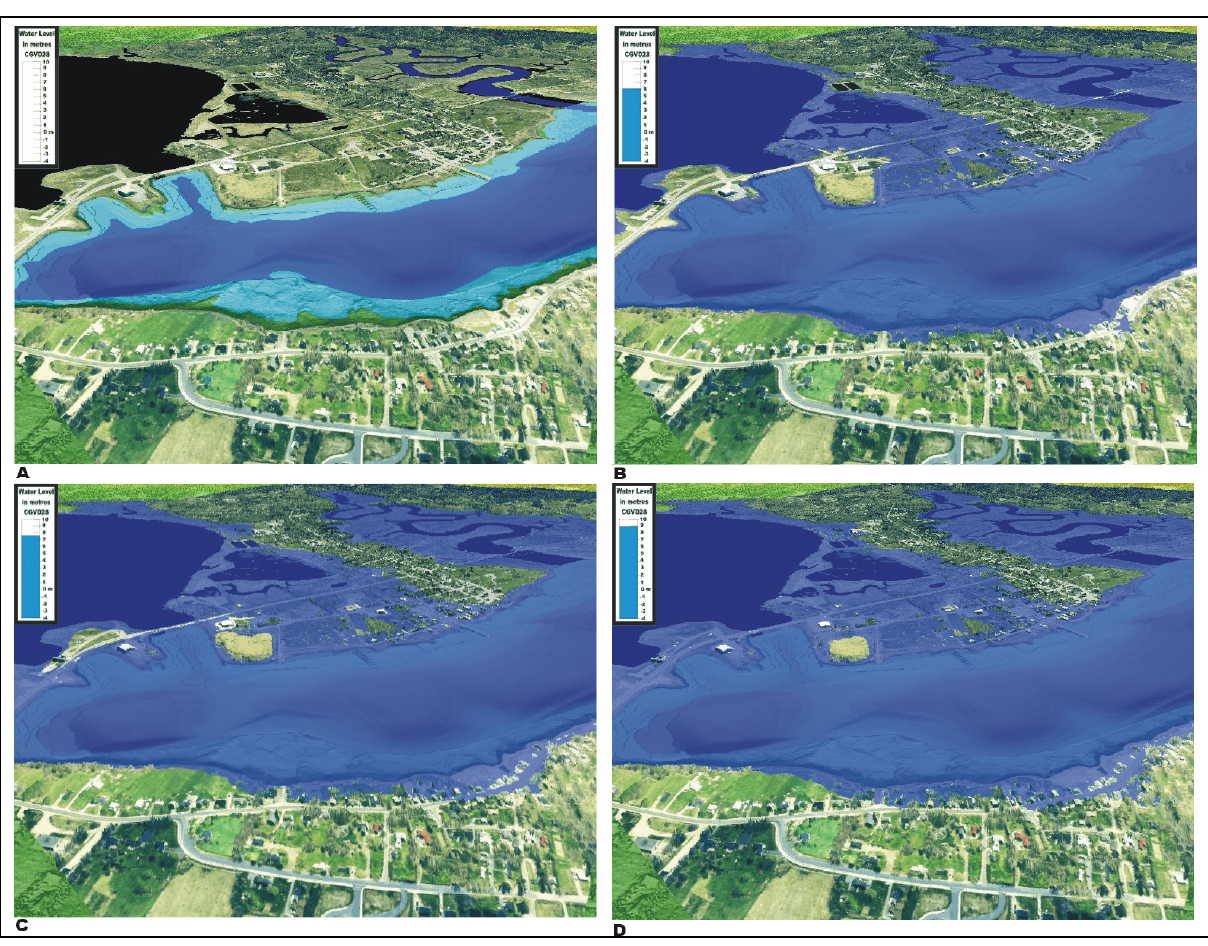
Figure 7. Perspective views of Annapolis Royal looking southeast. May 2003 color orthophoto and bathymetric data overlayed on the LiDAR DSM. (A) low tide (−4 m); (B) Groundhog Day storm in 100 years with a conservative RSL of 80 cm, (6.2 m); (C) Groundhog Day storm in 100 years with a potential RSL of 220 cm, (7.6 m); (D) highest predicted tide with a 2 m storm surge in 100 years with a potential RSL of 220 cm, (9.0